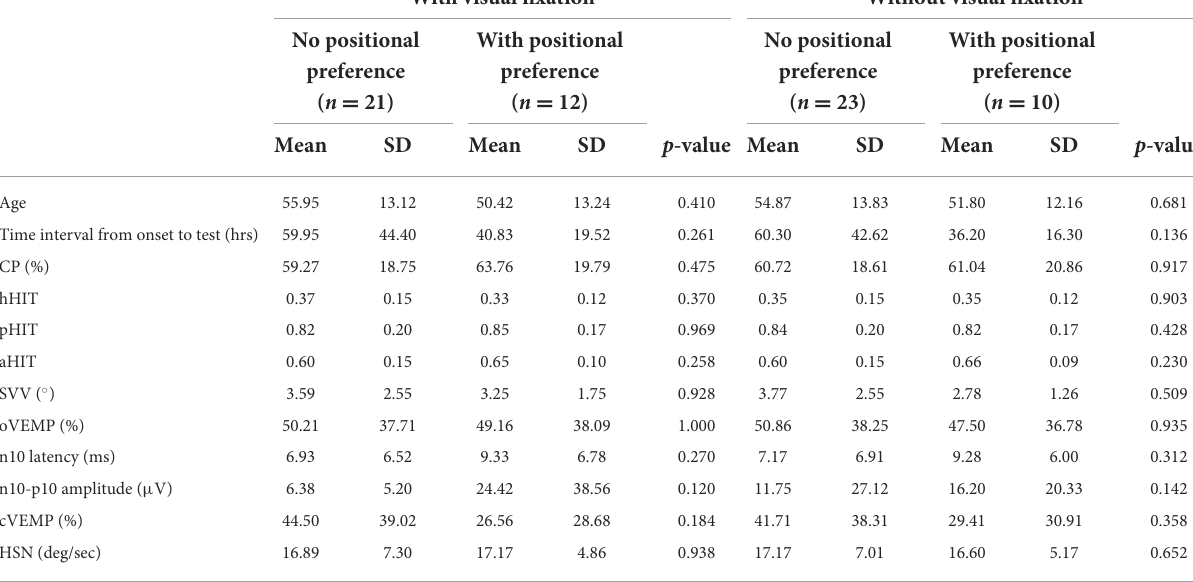
TABLE 3 Vestibular function test results between patients with and without positional preference. With visual fixation Without visual